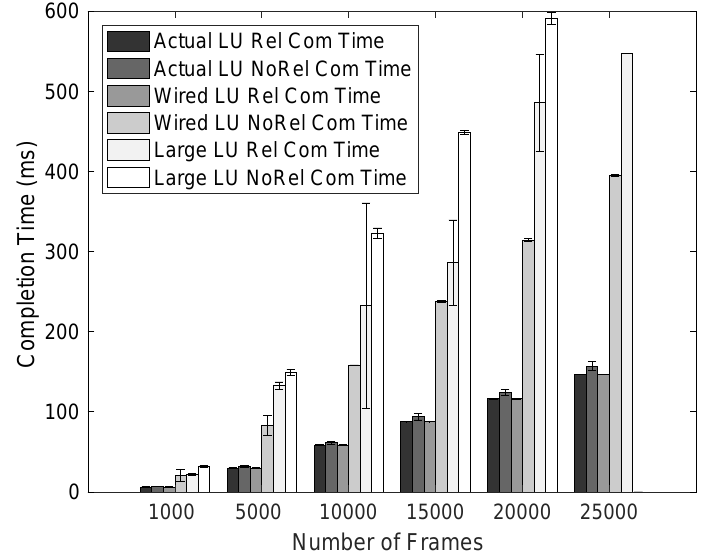
Figure 7. Schedule quality with and without relaxed constraints for different LU networks.